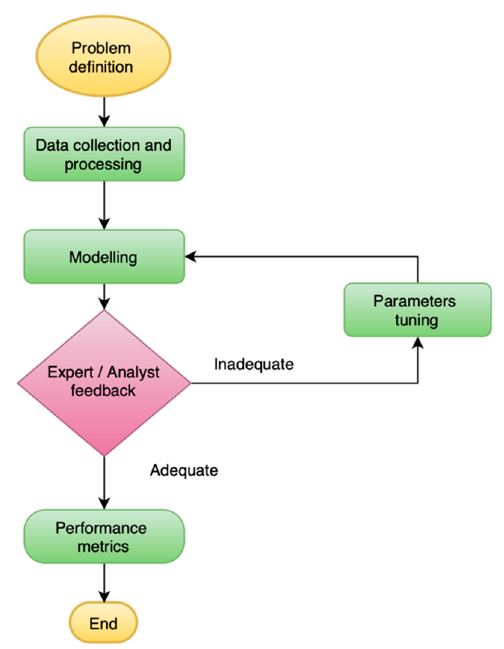
Figure 2. Modelling flowchart with analyst-in-the-loop.